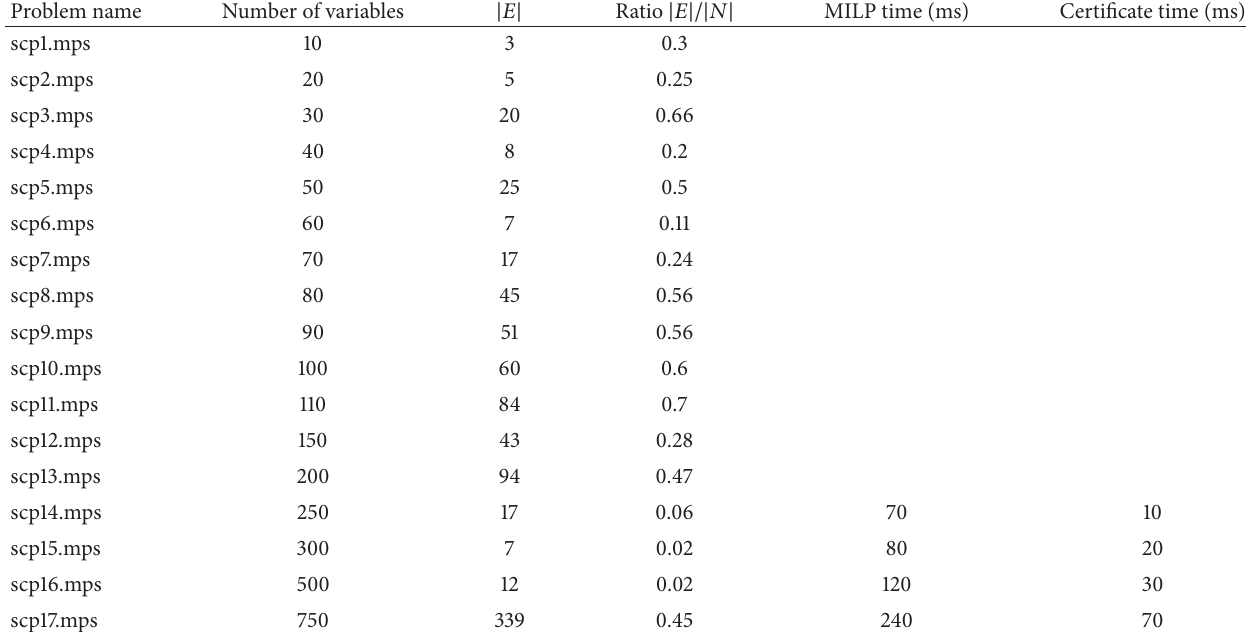
Table 5: Set covering